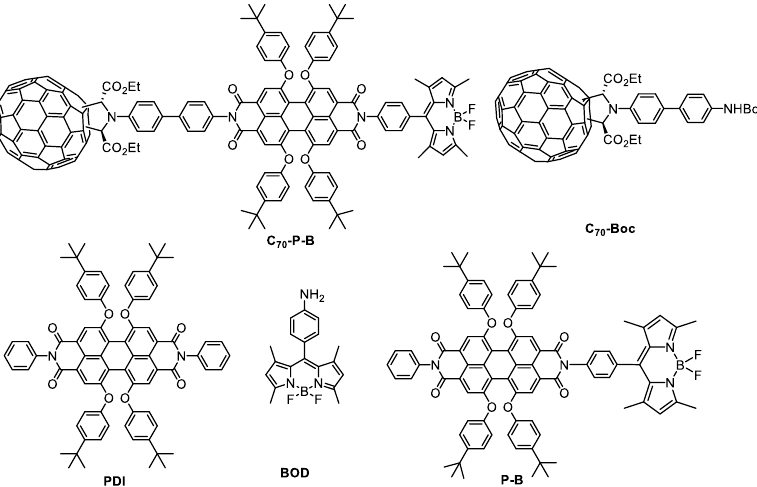
Figure 1. Molecules synthesized and studied in the present work.